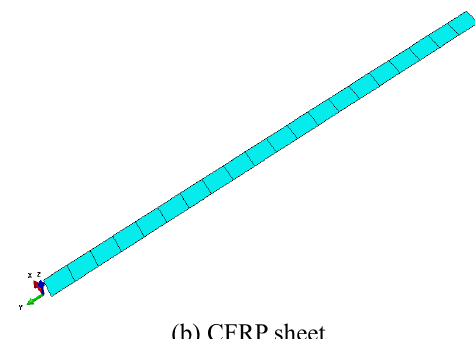
Figure 9. Mesh generation.